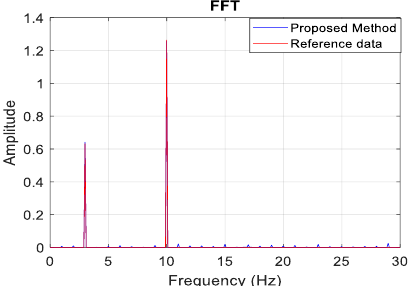
Figure 5. Frequency analysis of vibration